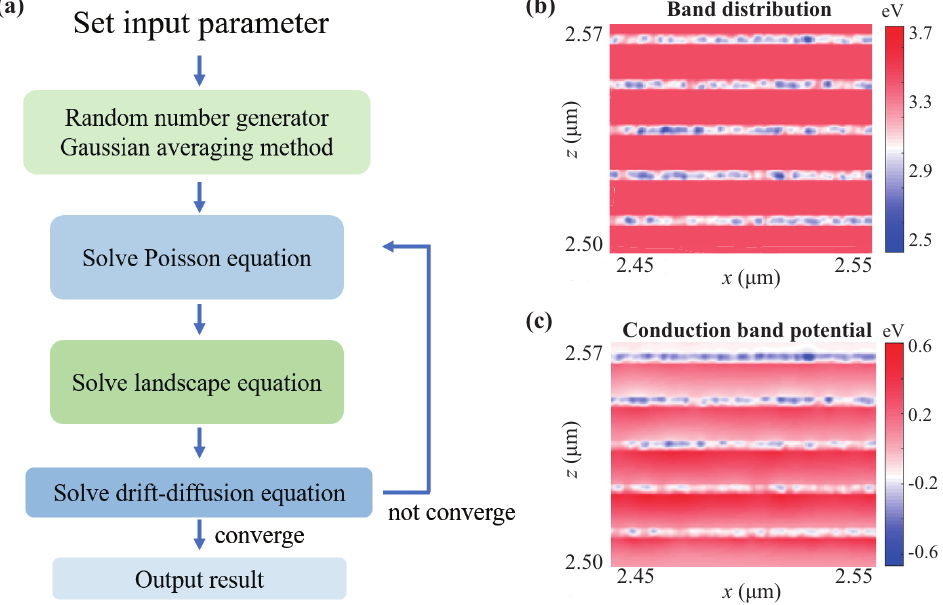
Figure 2. ( a ) Flow chart of the simulation model. ( b ) Bandgap distribution and ( c ) conduction band potential of the whole µ -LED with the random alloy fluctuations, which can be observed in the InGaN LED QWs. The fluctuating potential is a result of the inhomogeneous distribution of the bandgap. The following equations are used in the 2D